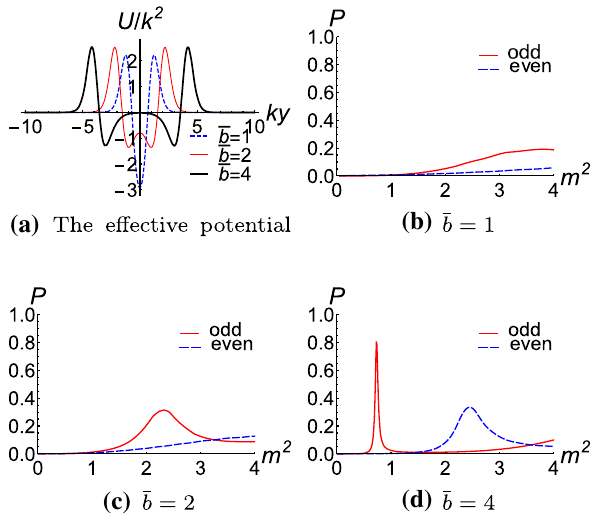
Fig. 2 The influence of the parameter ¯ b on the effective potential (45) and the relative probability P of f ( T ) = T for the odd-parity (red lines) and even-parity (blue dashed lines) massive KK modes